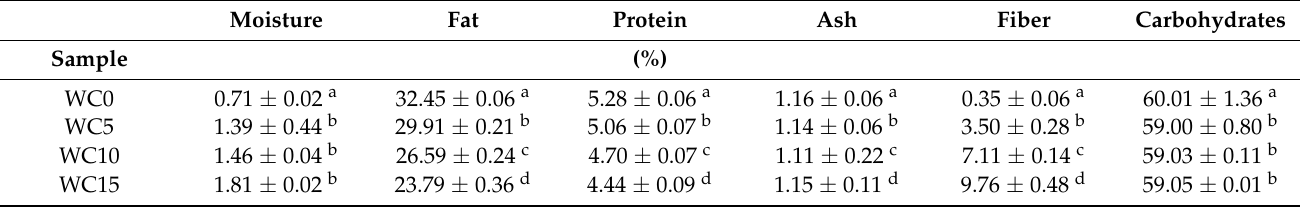
Table 5. Chemical composition of chocolate